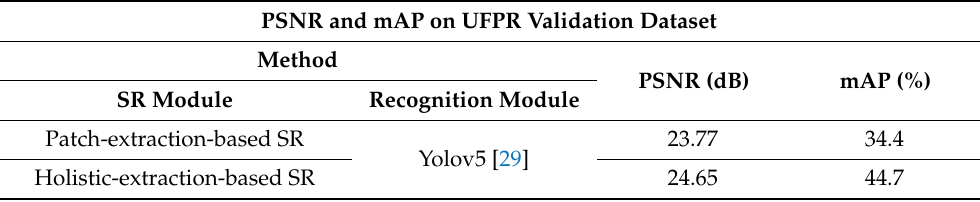
Table 5. Comparison between the patch extraction-based SR and the holistic extraction-based SR for scale factor ( × 4) on the UFPR dataset.